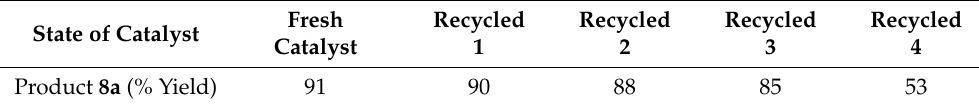
Table 3. Recyclability of the CS–CaO nanocomposite as a basic catalyst.